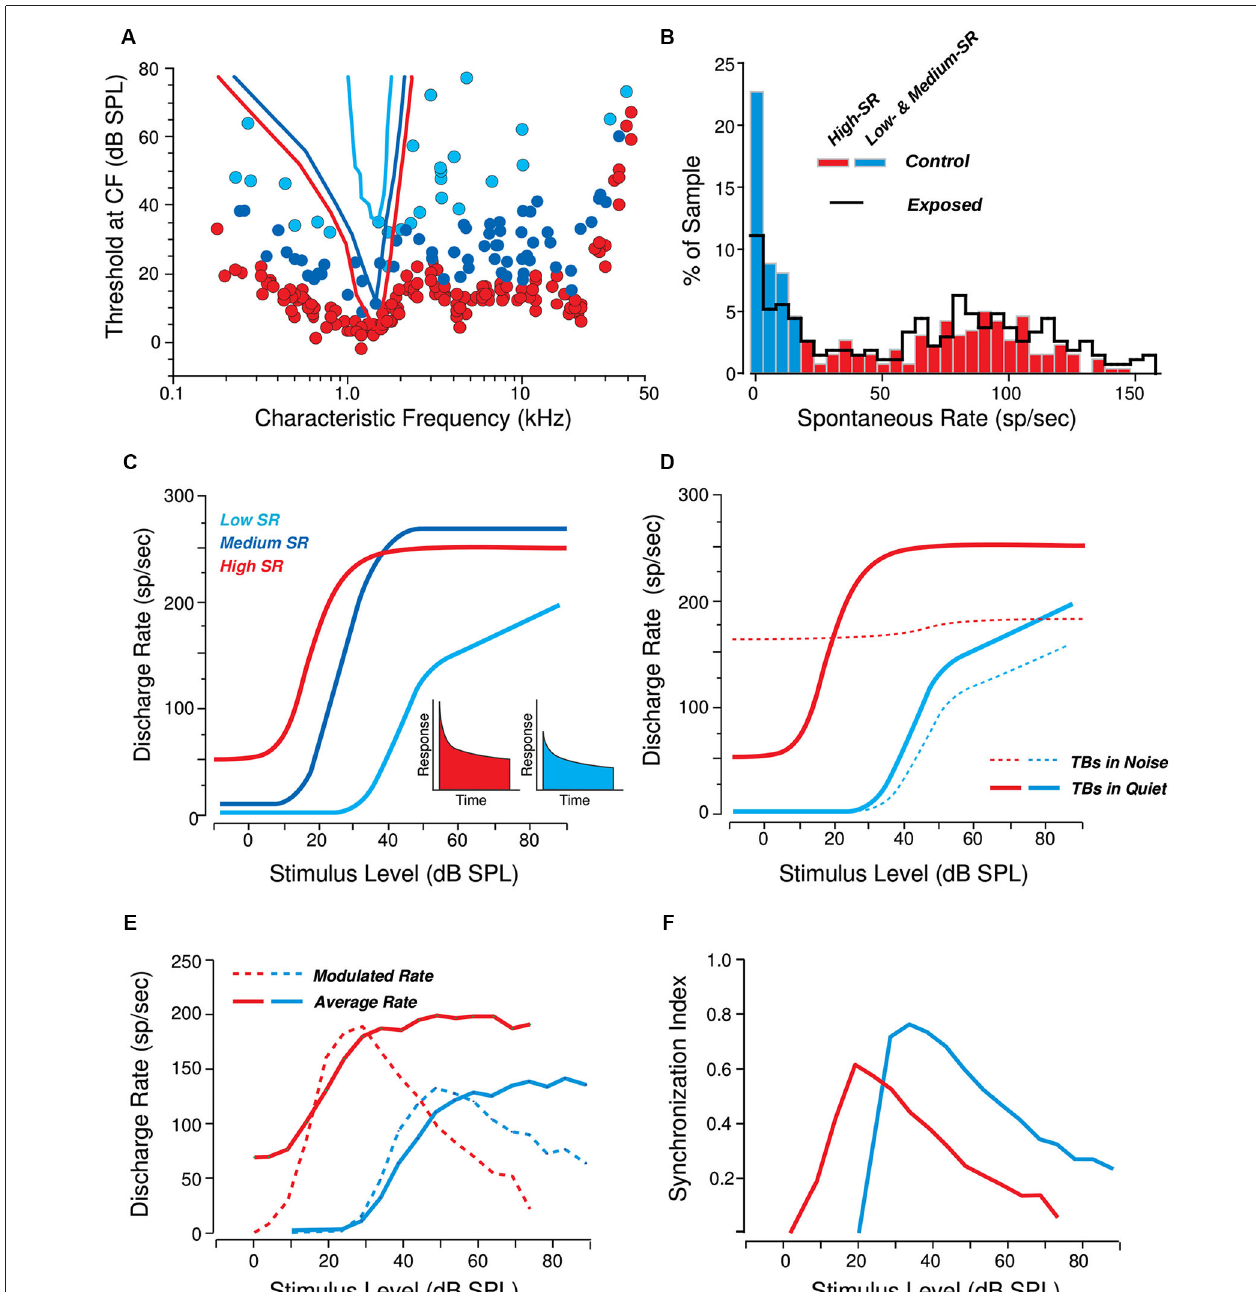
tone bursts (TBs) at the CF, in quiet (C) and in continuous background noise at a fixed 0 dB spectrum level (D) . Data from cat (Liberman, 1978; Costalupes et al., 1984). The insets in panel C show schematic peri-stimulus time histograms of the response to a moderate-level tone burst: onset rates are higher in the high-SR fiber than in the low-SR fiber. (E, F) Responses to SAM tones in high- vs. low-SR fibers expressed as average rate and modulated rate (E) or average synchrony ( F ; see text for definitions). Responses are to carrier tones at the CF, amplitude modulated (AM) at 100 Hz. Data from cat (Joris and Yin,